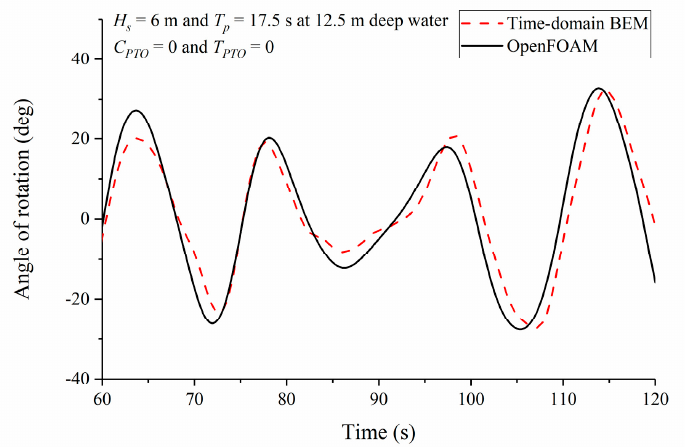
= 0 and (cid:3017)(cid:3021)(cid:3016) = 6 m and 𝑇 = 17.5 s ) in (cid:3046) (cid:3043)